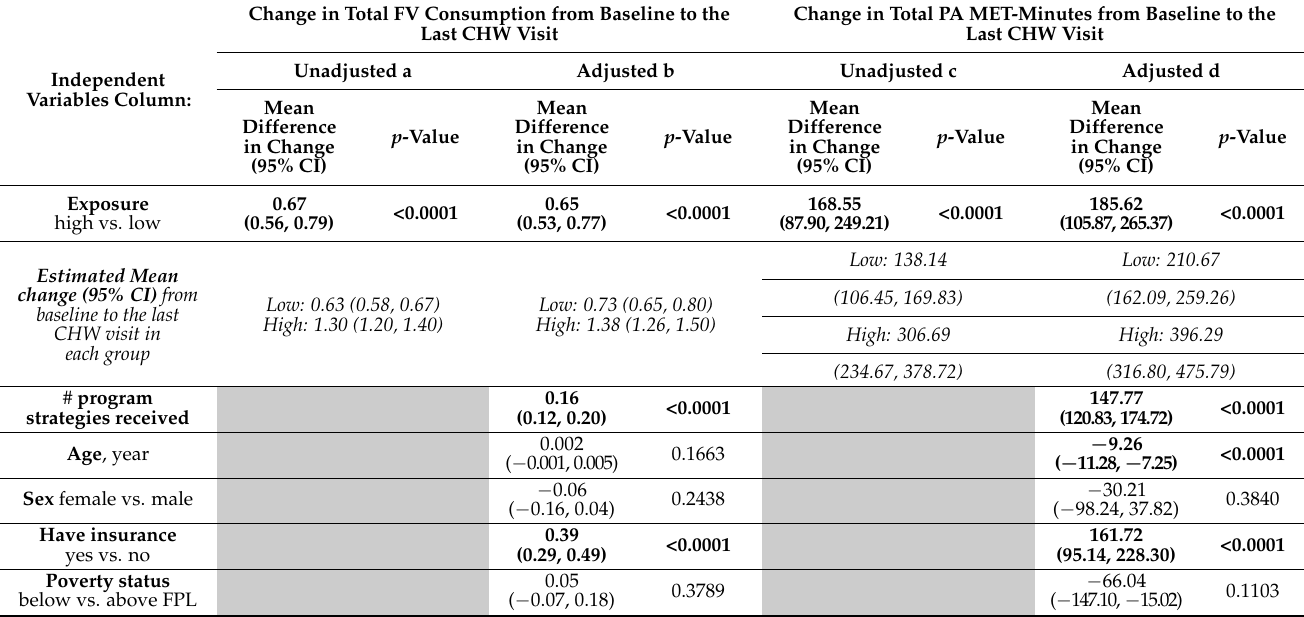
Table 3. TSSC program effect on change in FV and PA MET-minutes from baseline to last visit based on linear regression analysis ( n =